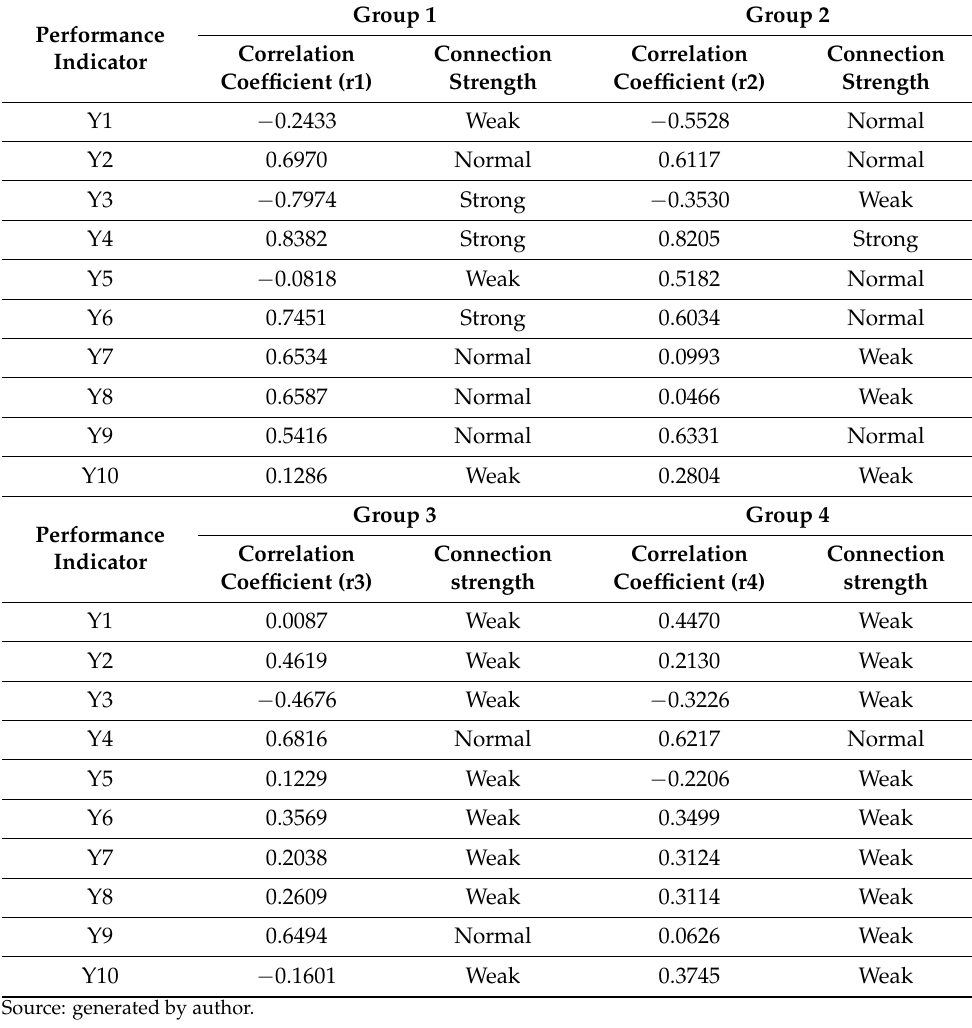
Table 5. Correlation coefficients of performance indicators of commercial banks and the level of digital maturity of the bank by groups of banks.